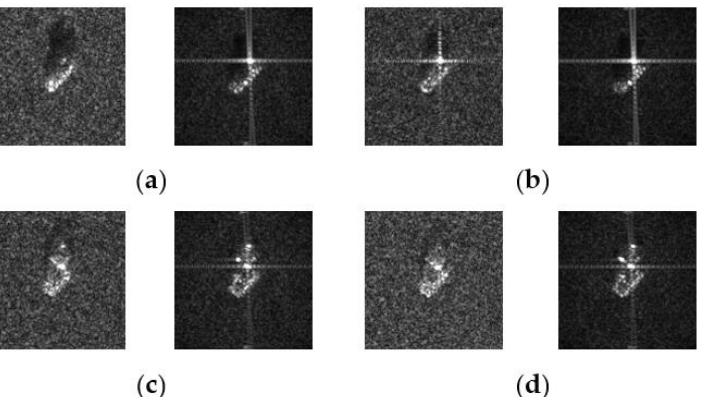
Figure 12. Real and synthesized SAR image samples for M35 and M548. ( a ) M35 El = 16°, Az = 37°; ( b ) M35 El = 17°, Az = 37°; ( c ) M548 El = 16°, Az =56°; ( d ) M548 El = 16°, Az =56°.